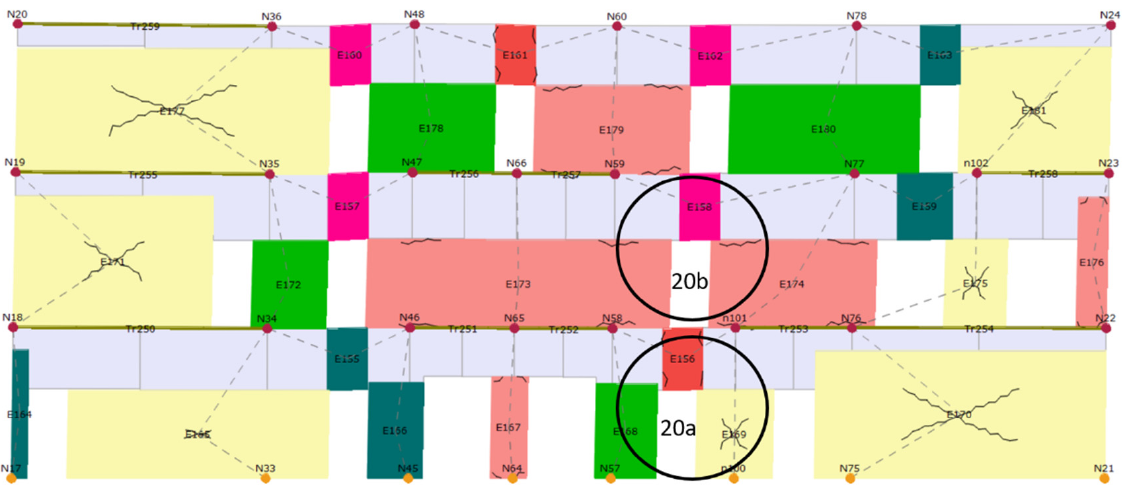
Figure 19. Damage to the central wall in the x -direction (3Muri).